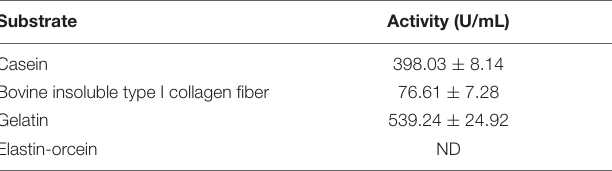
TABLE 1 | The substrate specificity of the extracellular protease of strain